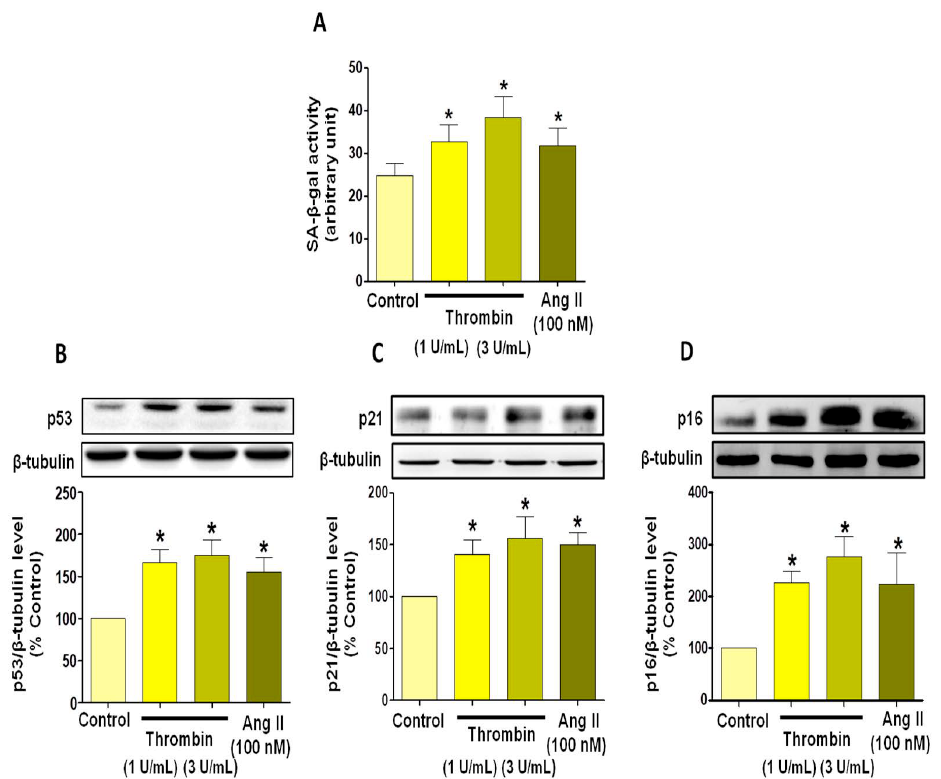
Figure 1. Thrombin and angiotensin II (AngII) induce senescence in atrial endothelial cells (ECs) at passage 1 and are associated with an up-regulation of major cell cycle regulatory proteins: p53, p21 and p16. Atrial ECs were either untreated or exposed to thrombin (1 or 3 U/mL) or AngII (100 nM) for 24 h before determination of senescence by SA- β -galactosidase (SA- β gal) activity ( A ) and protein expression level of ( B ) p53, ( C ) p21 and ( D ) p16 by Western blot analysis. Results are presented as representative immunoblots (upper panels), and corresponding cumulative data (lower panels) and are shown as mean ± SEM of n = 3–4 different experiments. * P < 0.05 versus respective